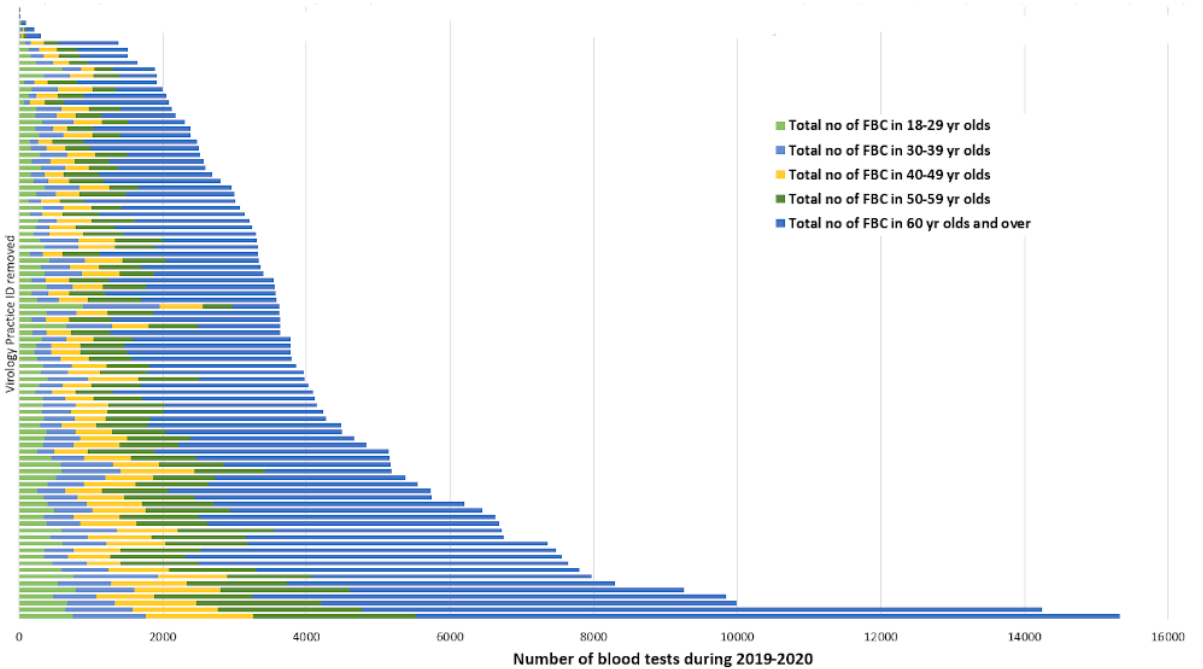
Figure 7. Number of blood tests in Adults.